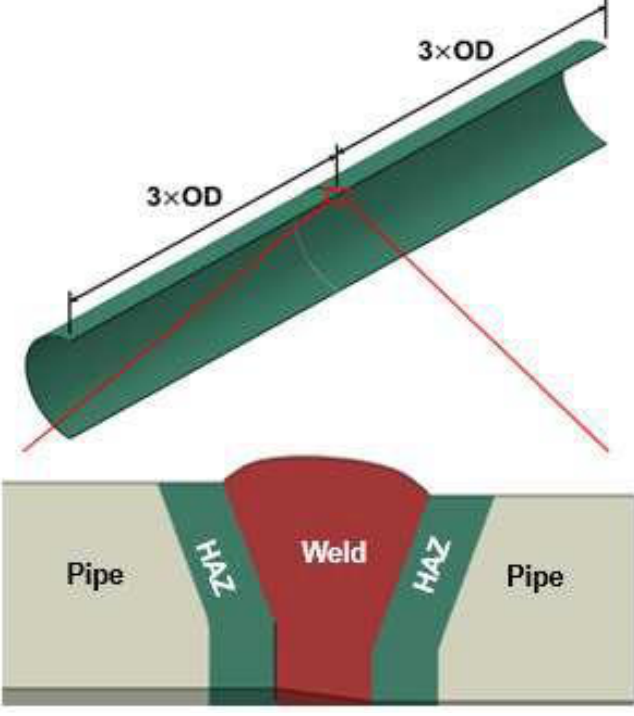
Figure 6. A typical FE model used in the